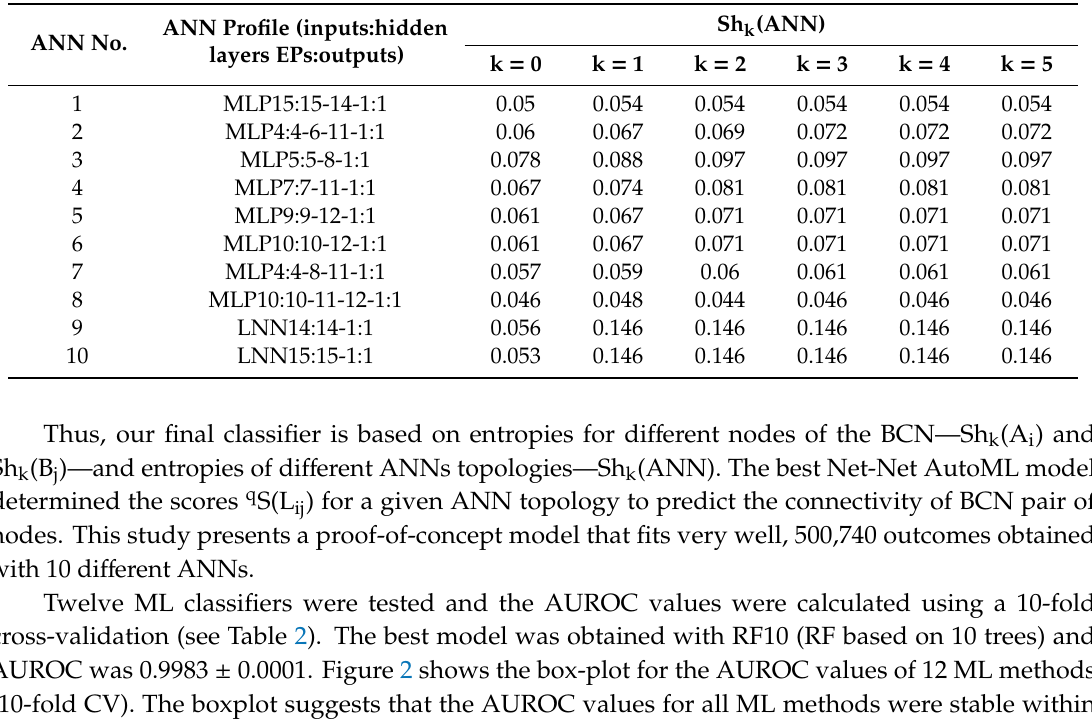
Table 1. Information indices Sh k (ANN) of the ANNs used as inputs to find the best Net-Net Automated Machine Learning (AutoML)